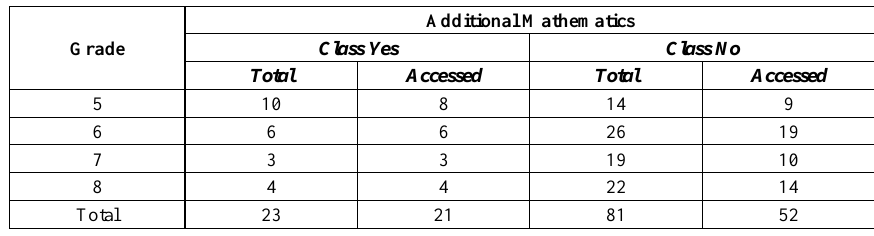
Table 3. Description of the dataset